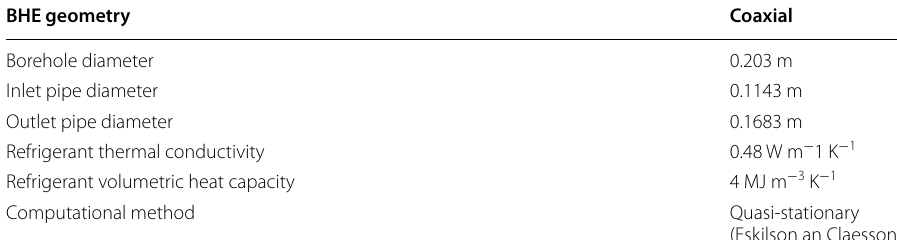
Table 1 Parameters of the coaxial borehole heat exchangers